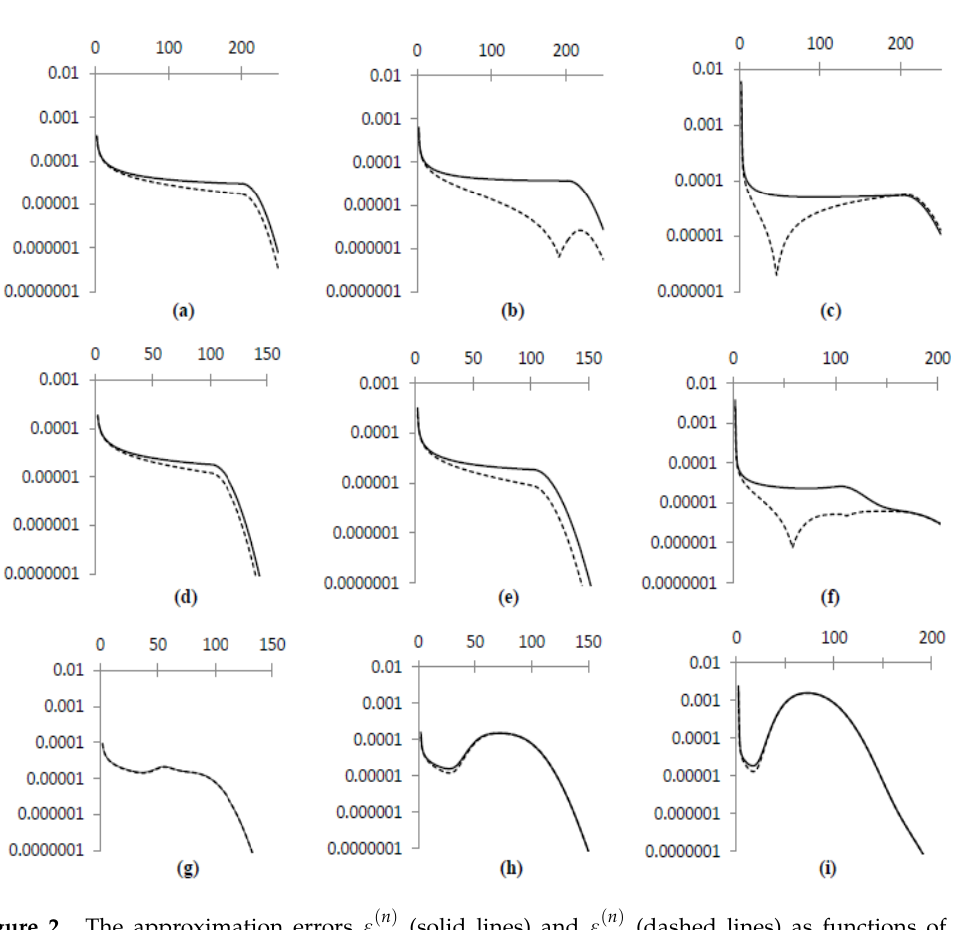
Figure 2. The approximation errors ε ( a ) m = 0.5, s = 1.5; ( b ) m = 0.5, s = 2.0; ( c ) m = 0.5, s = 3.0; ( d ) m = 1.0, s = 1.5; ( e ) m = 1.0, s = 2.0;